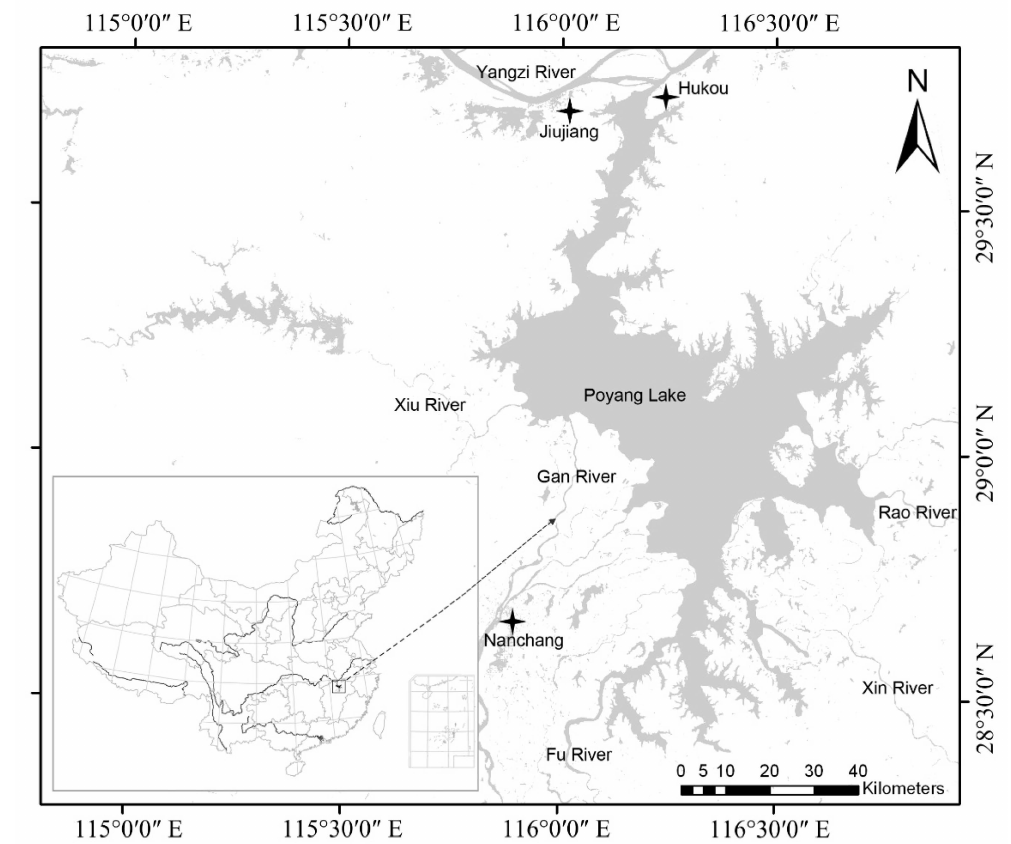
Figure 1. Research area in this